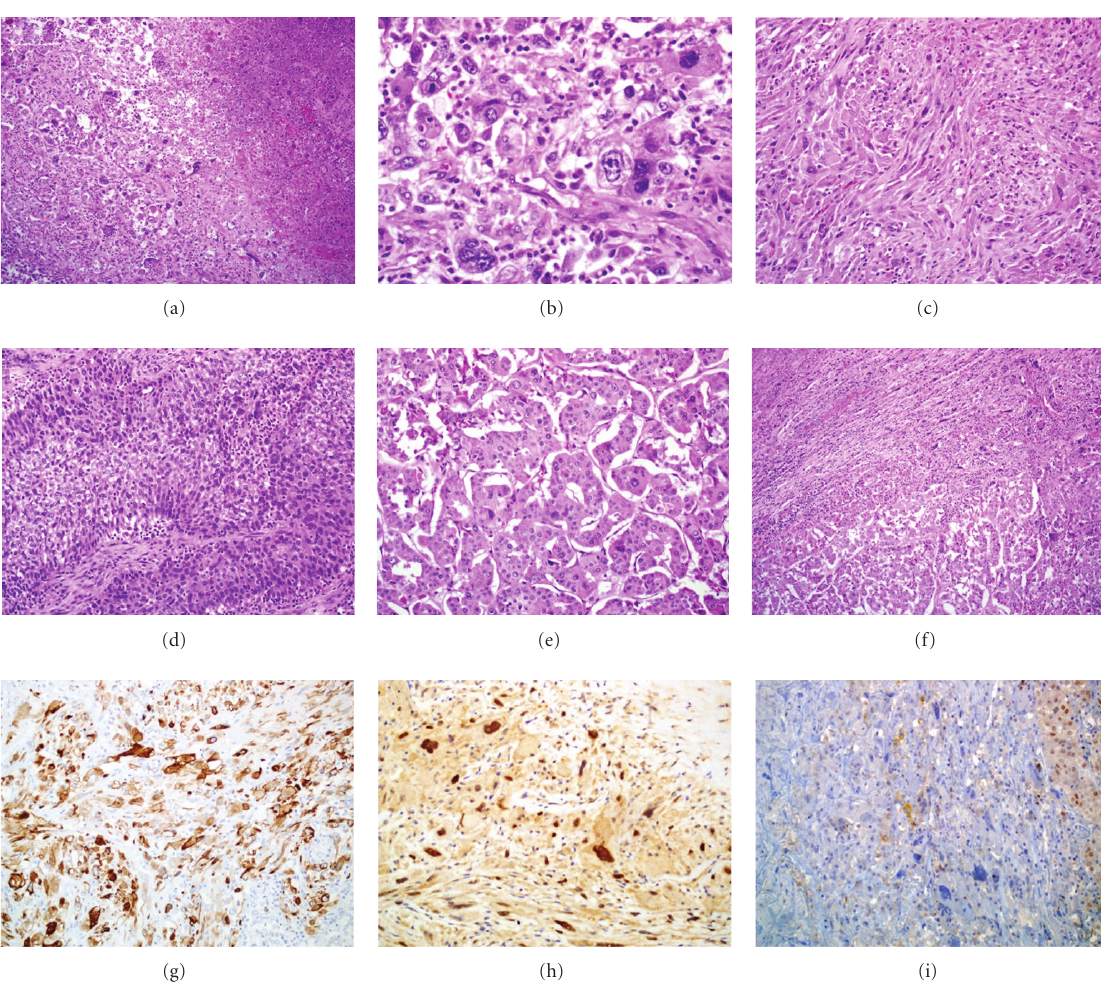
Figure 2: Postoperative histopathology of the resected tumor. (a) The thyroid tumor featured large zones of necrosis (right) (hematoxylin and eosin, × 100). (b) The tumor was composed of highly pleomorphic cells with large, bizarre nuclei containing prominent nucleoli and mitotic figures. Much of the tumor was infiltrated by neutrophils, a common feature of anaplastic thyroid carcinoma (hematoxylin and eosin, × 400). While the predominant pattern of the tumor was pleomorphic/giant cell, there were areas that were spindled (c) hematoxylin and eosin, × 200) or epidermoid (d) hematoxylin and eosin, × 200). (e) Focally admixed with the undi ff erentiated tumor was a well-di ff erentiated oncocytic component (hematoxylin and eosin, × 200). (f) The well-di ff erentiated component transitioned directly into the predominant anaplastic component. The anaplastic carcinoma was positive for cytokeratins AE1/AE3 (g) (AE1/AE3 immunohistochemistry, × 200) and PAX8 (h) (PAX8 immunohistochemistry, × 200). (i) The well-di ff erentiated component of the tumor (right) expressed thyroid transcription factor-1, while the anaplastic component (left) did not (thyroid transcription factor-1 immunohistochemistry, ×